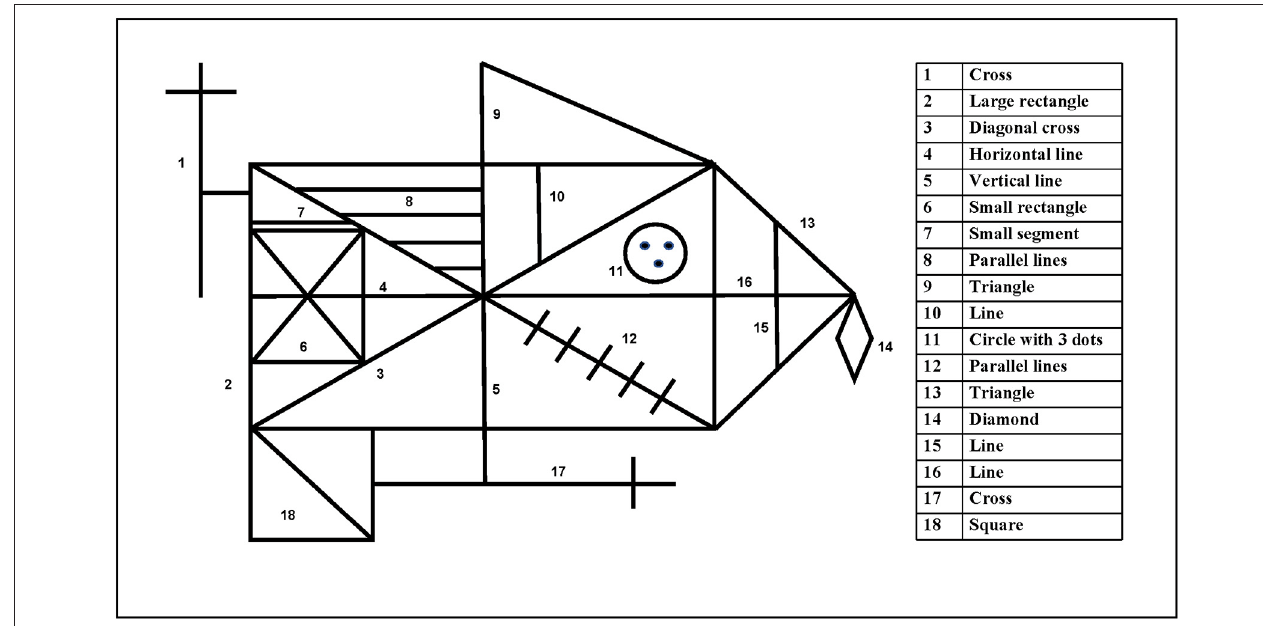
FIGURE 2 | The 18 scoring units of the Rey–Osterrieth Complex Figure.